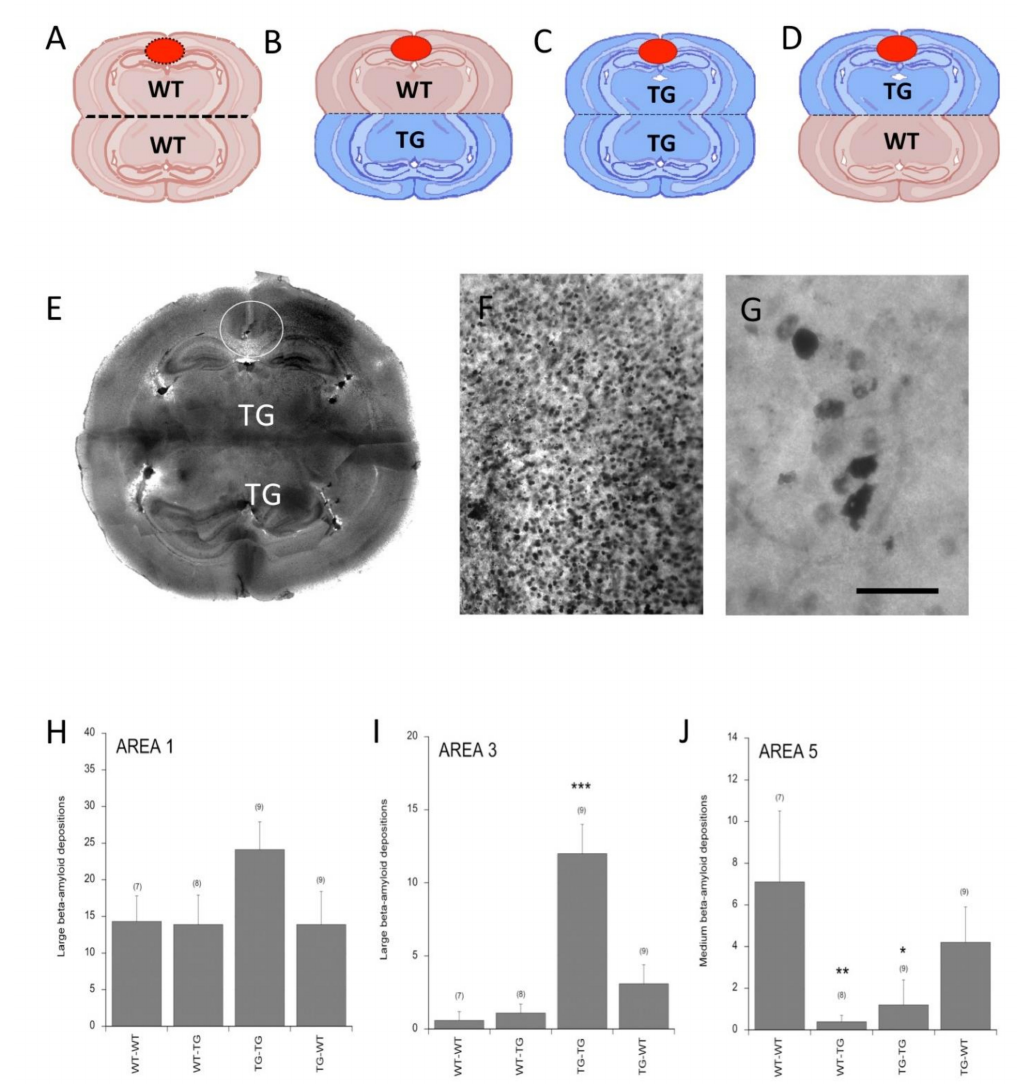
Figure 6. Beta-amyloid spreading in slices taken from transgenic (TG) mice (APP_SweDI). Coronal half-brain co-slices were prepared from wildtype (WT) (donor)–wildtype ( A ), wildtype (donor)–transgenic ( B ), transgenic (donor)–transgenic ( C ) and transgenic (donor)–wildtype ( D ) mice, and after one week collagen hydrogels loaded with human beta-amyloid-42 were applied and slices incubated for eight weeks. An overview showed strong beta-amyloid staining all over the two brain slices taken from transgenic mice ( E ). The hydrogel is marked with a white circle ( E ). A higher magnification is given in ( F ) and ( G ) from the cortical area. The number of beta-amyloid depositions was evaluated in area 1 ( H ), area 3 ( I ) and area 5 ( J ). Computer-assisted analysis of large ( H , I ) and medium ( J ) depositions was performed and values are given as means ± SEM; values in parenthesis give the number of animals. Statistical analysis was performed by one-way ANOVA with a subsequent Fisher LSD post hoc test compared to the WT–WT slices (* p < 0.05; ** p < 0.01; *** p < 0.001). Scale bar in G = 250 µ m ( E ), 480 µ m ( F ) and 80 µ m ( G